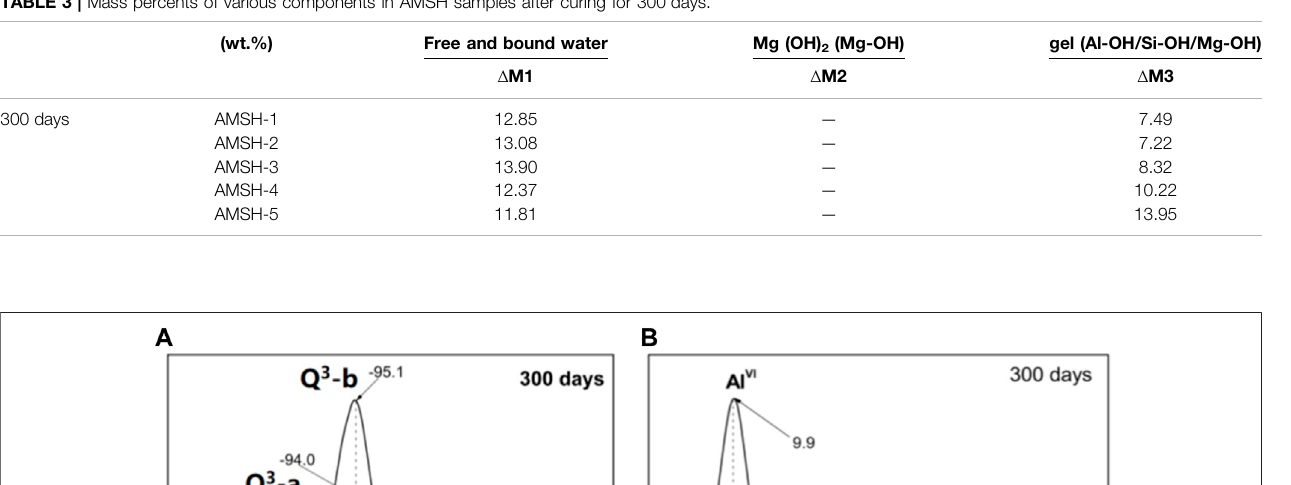
Frontiers in Materials |